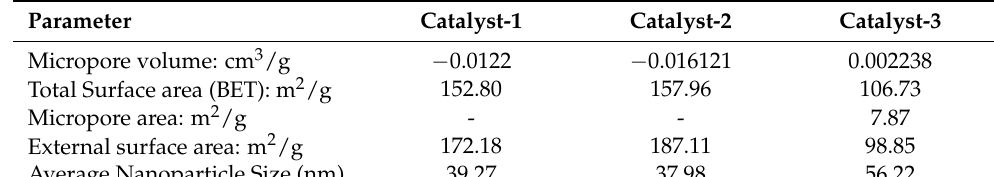
Table 2. Parametric characteristics of nickel oxide catalysts samples.